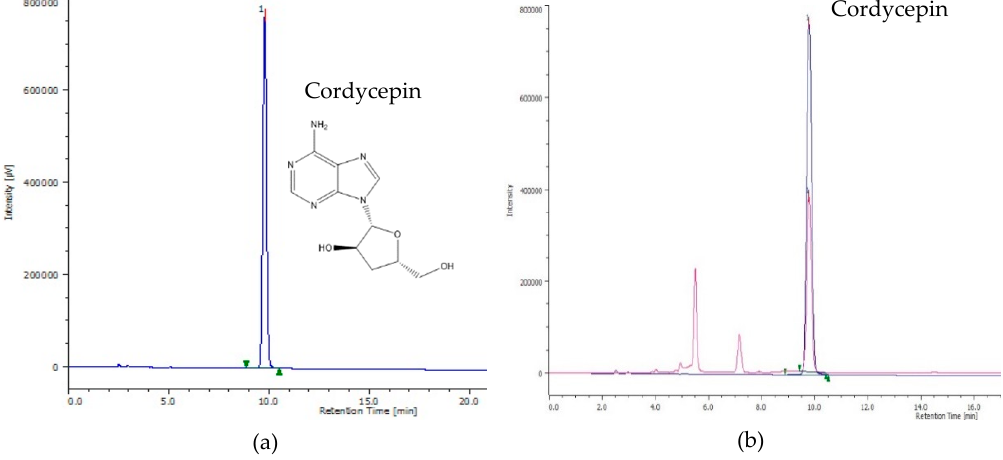
Figure 8. ( a ) HPLC chromatograms of synthetic cordycepin as standard, ( b ) HPLC chromatograms of cordycepin in the CM4 fraction compared with the standard (0.5 mg/mL).